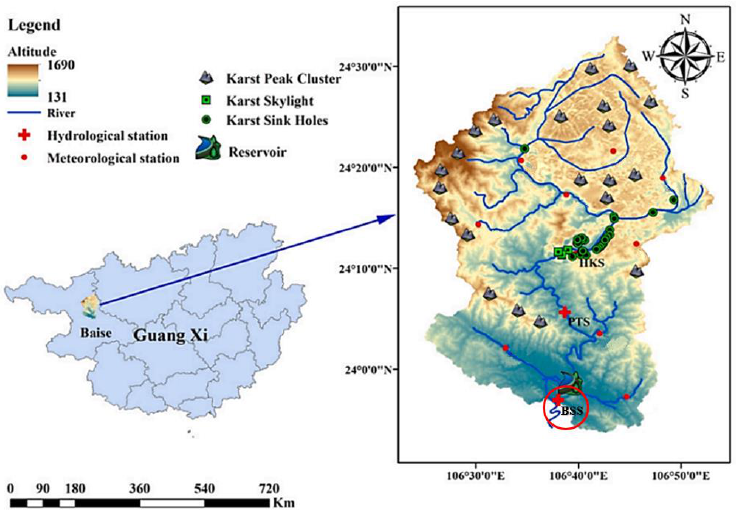
Figure 1. The approximate locations of the Chengbi River Karst